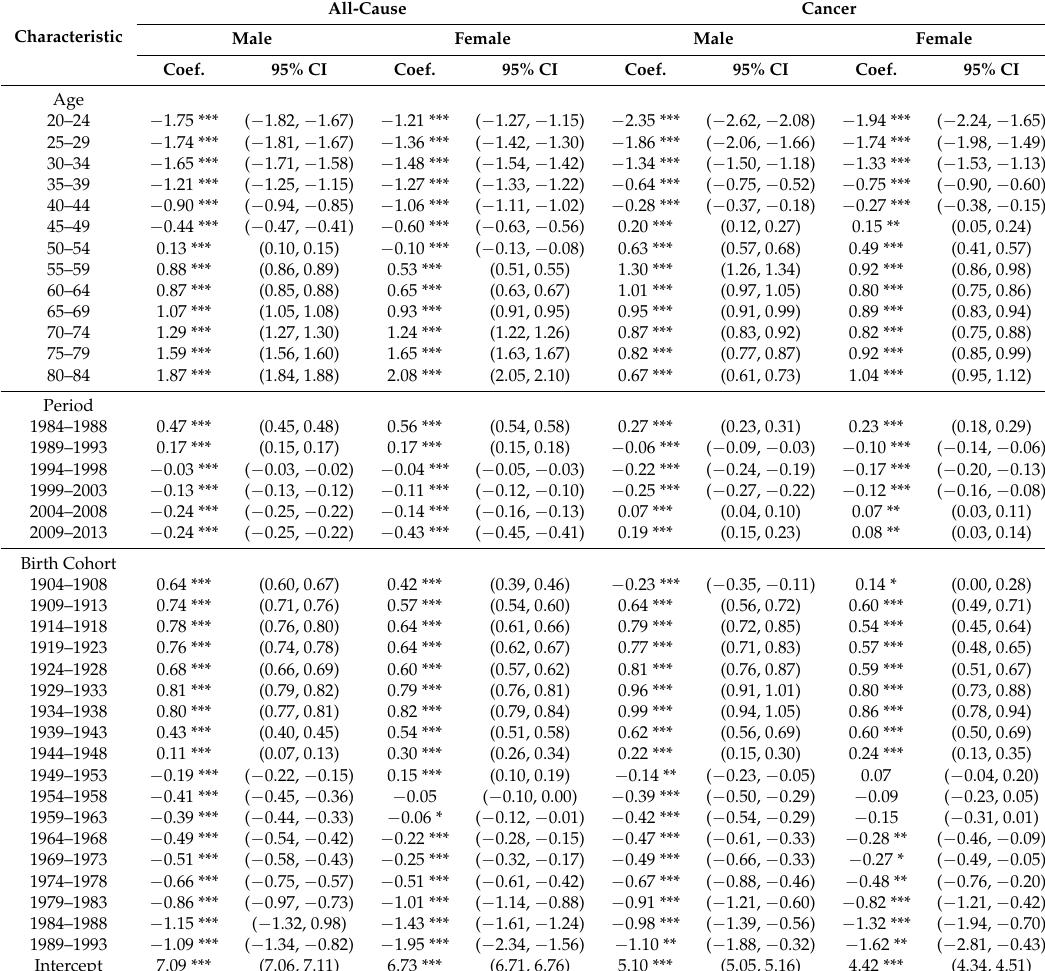
Table 1. APC model analysis results of all-cause and cancer mortality in